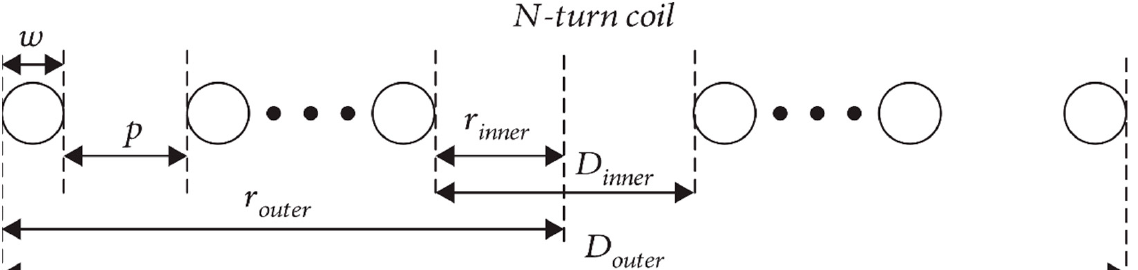
Figure 6. Schematic diagram of the spiral coil cross-section.